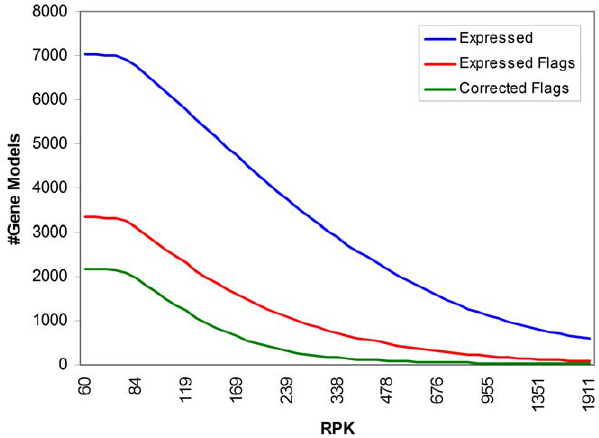
Figure 2. Relationship between the RPK expression levels and gene model characteristics. The traces represent the total number of gene models expressed (blue line) at or above some minimum RPK (log scale), the number of models in the subset of expressed genes that have at least one detectable internal sequence deviation (red line), and total number of expressed models that still contain at least one detectable internal sequence deviation after attempts were made to bridge those flags with the set of expressed RNAseq data (green line).